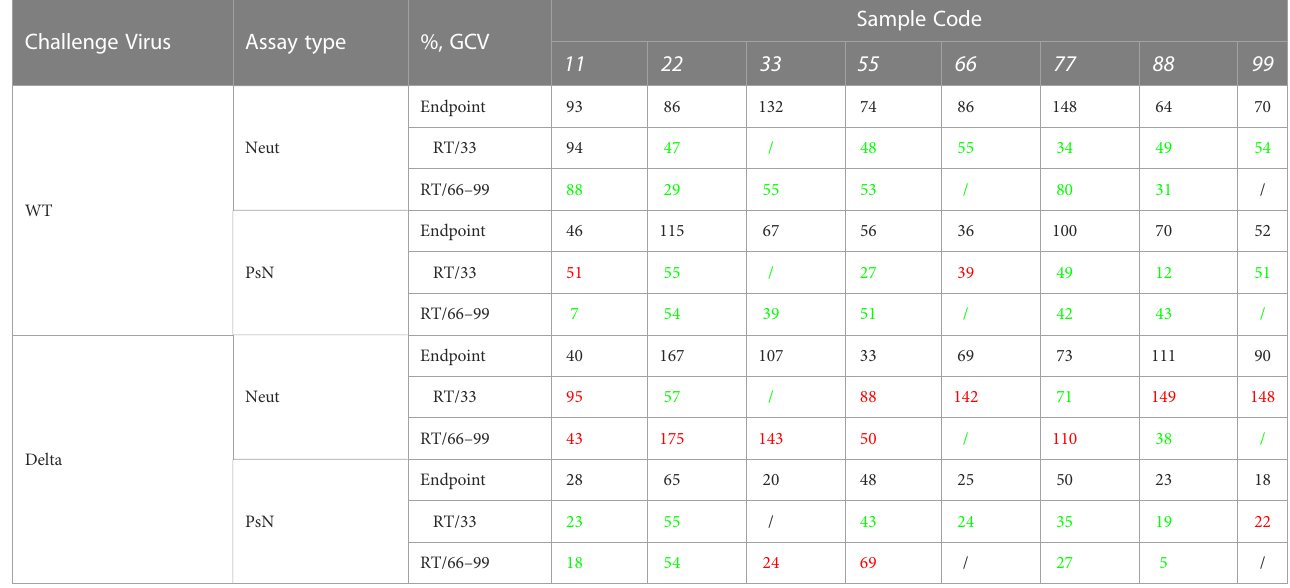
Green represents lower GCV of relative titers than that of endpoint titers, and red represents higher GCV of relative titers than that of endpoint titers. To assess the suitability of samples 33 and 66 – 99, the neutralization relative titers (RT) for each sample were calculated relative to samples 33 and 66 – 99 in each assay. The GCV of the endpoint titer, RT/33, and RT/66 – 99 among all participants was statistically analyzed to re fl ect variability between different laboratories. WT, wild-type; PsN, pseudovirus neutralization assay; Neut, live virus neutralization assay.